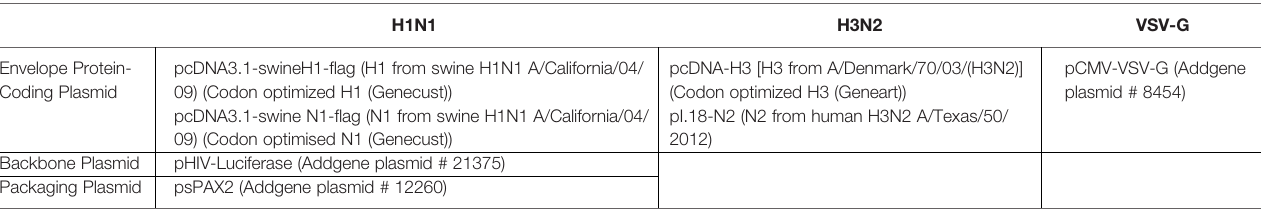
TABLE 1 | Plasmids used for pseudotyped lentivirus particle production (33). H1N1 H3N2 VSV-G Envelope Protein- Coding